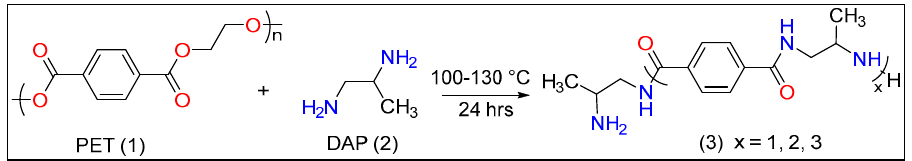
Figure 1. Chemical conversion of PET to corresponding amide.